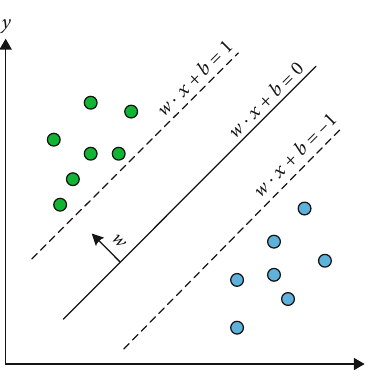
Figure 1: Schematic diagram of the SVM